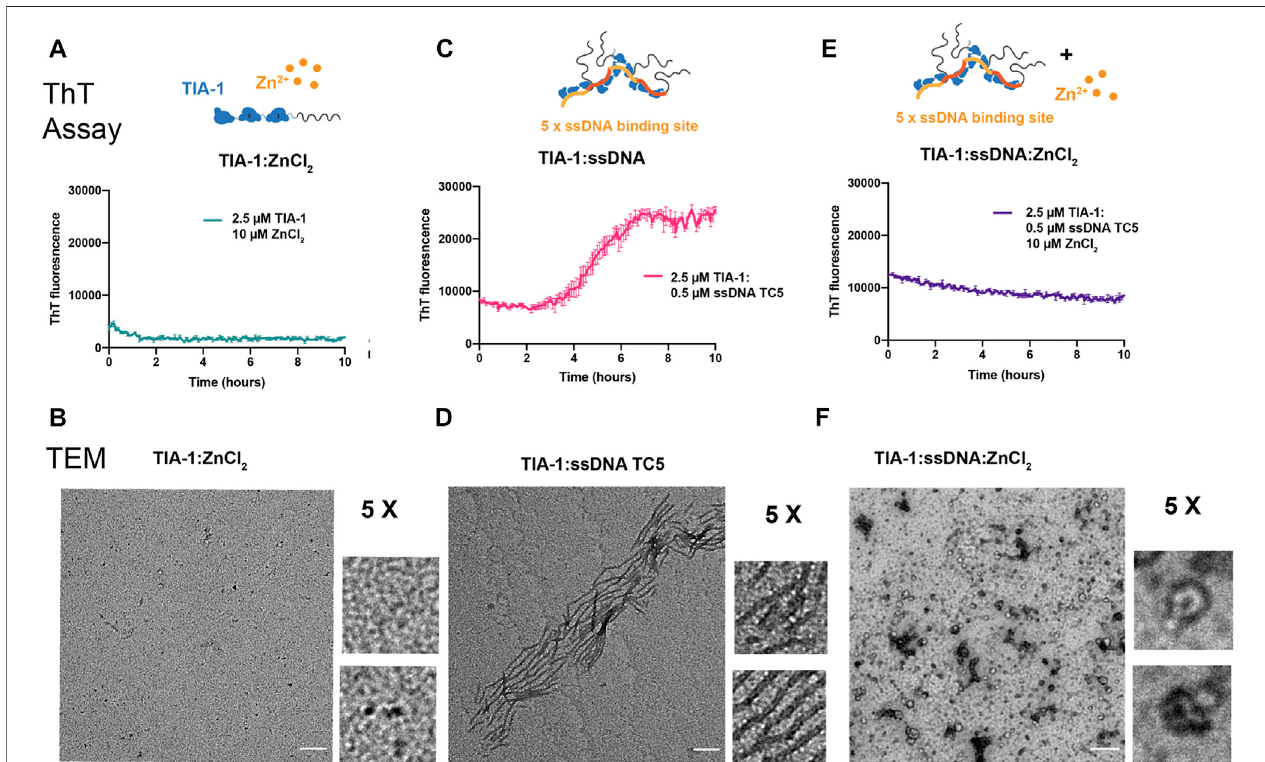
FIGURE 3 | Zinc inhibits fi brillar aggregation of TIA-1. Thio fl avin T (ThT) fl uorescence assay monitoring the formation of ThT positive aggregates ( top ) and TEM of μ M TIA-1, 0.5 μ M ssDNA TC5 (E,F) 2.5 μ M TIA-1, 0.5 μ M ssDNA TC5, 10 μ M ZnCl fi nal samples ( bottom ) (A,B) 2.5 μ M TIA-1, 10 μ M ZnCl 2 (C,D) 2.5 20 mM HEPES, 50 mM NaCl, 15 mM Arginine, pH 7.2, at 30 ° C with shaking. 3 replicates. Errors represent S.D. Scale bar represents 200